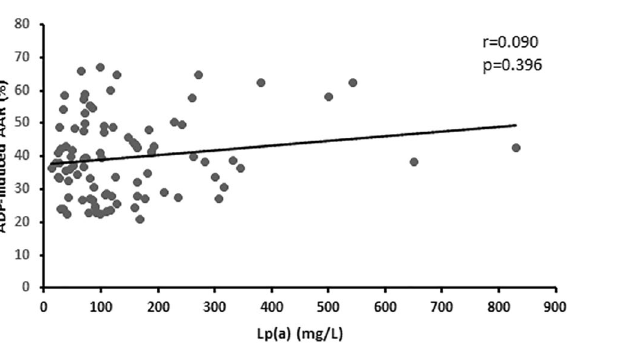
Figure 3. Association between Lp(a) levels and ADP-induced platelet average aggregation rate in subjects. Univariate linear correlation analysis of serum Lp(a) levels with ADP-induced platelet average aggregation rate